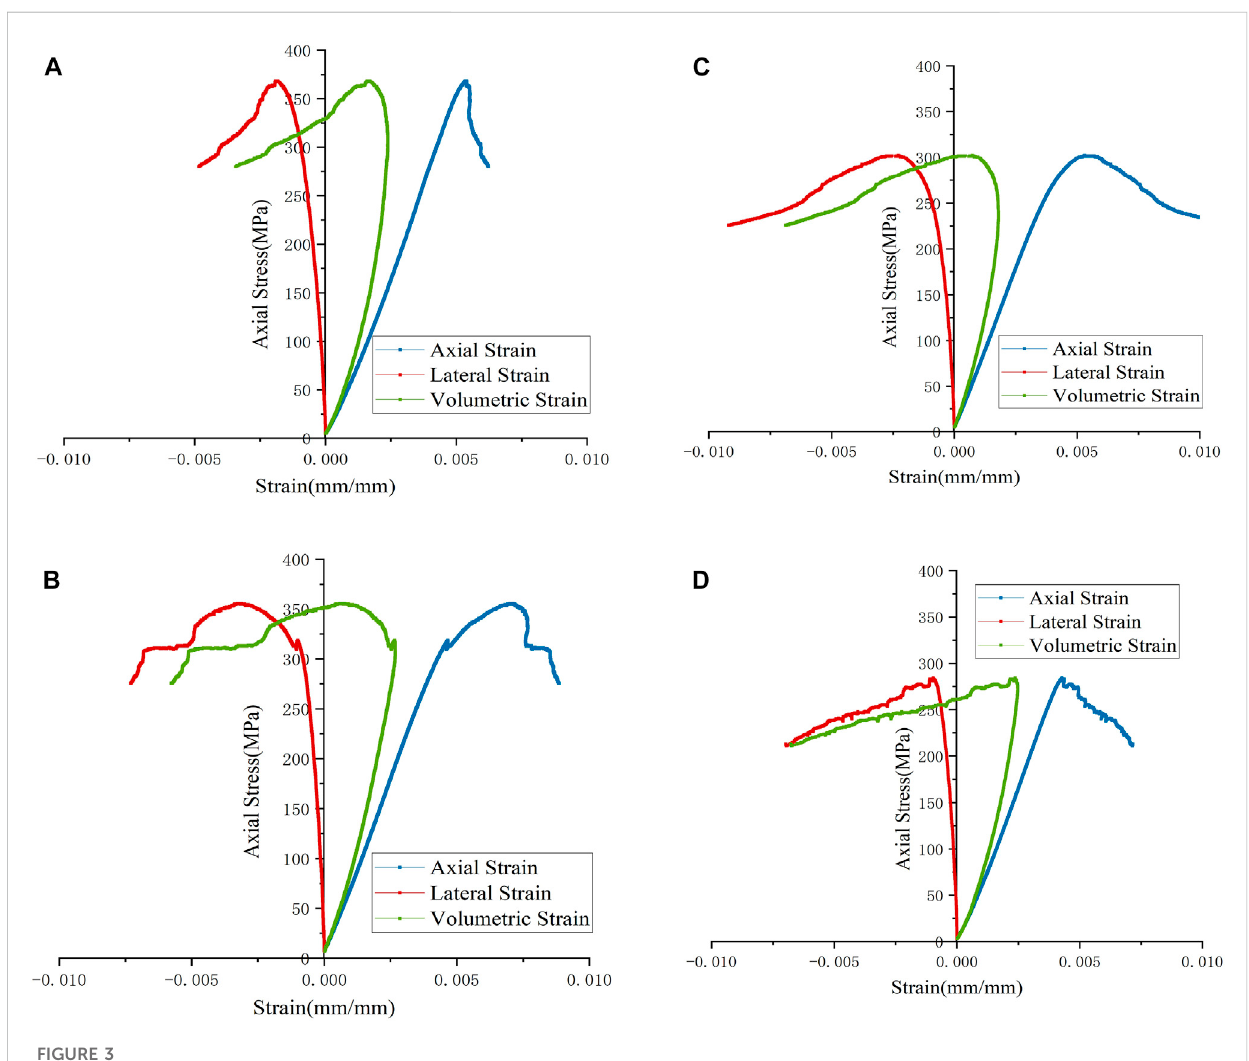
FIGURE 3 Stress strain curve of triaxial rock mechanics (A – D) .